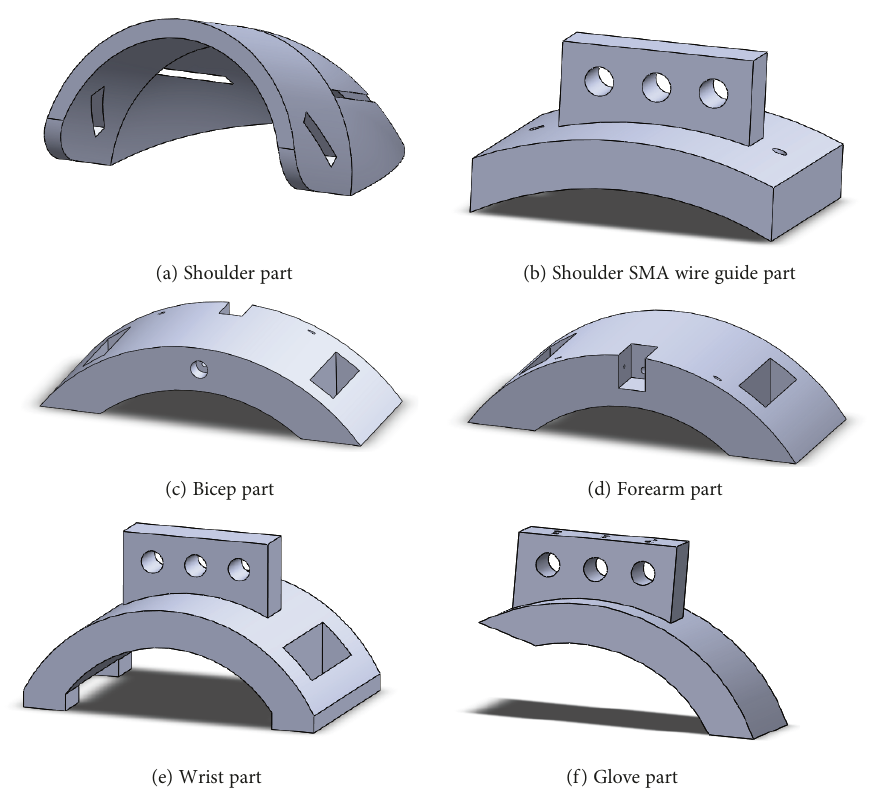
Figure 6: Elbow exoskeleton 3D-printed parts.